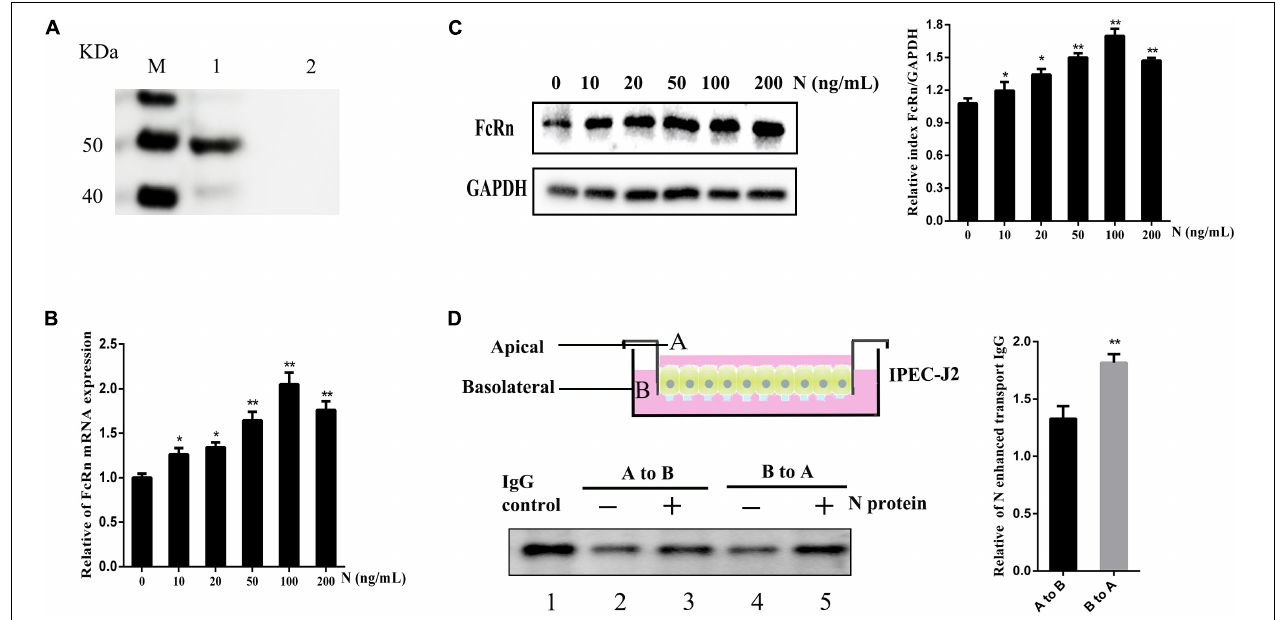
FIGURE 6 | Effects of recombinant TGEV N stimulation on the IgG transcytosis in IPEC-J2 cells. (A) Analysis of recombinant TGEV N protein by Western blot. M: Protein marker. 1: TGEV recombinant N. 2: Negative Control. IPEC-J2 cells were treated with recombinant TGEV N protein (0, 10, 20, 50, 100 or 200 ng/mL) for 12 h. (B,C) FcRn expression levers were detected by RT-qPCR and Western blot. The right panel represents the quantification of the bands by densitometry, corrected by the amount of GAPDH. (D) Transwell system used throughout this study. A, apical; B, basolateral. IPEC-J2 cells were grown in a 12-well transwell plate about 6–7 day until TEER > 1000 (cid:127) /cm 2 . IPEC-J2 cells were stimulated with or without recombinant TGEV N (100 ng/ml) for 12 h. Cells were loaded with porcine biotin-IgG at 37 ◦ C in either the apical (lanes 2 and 3) or basolateral (lanes 4 and 5) chamber. Lane 1 represents an IgG. ∗ p < 0.05, ∗∗ p <